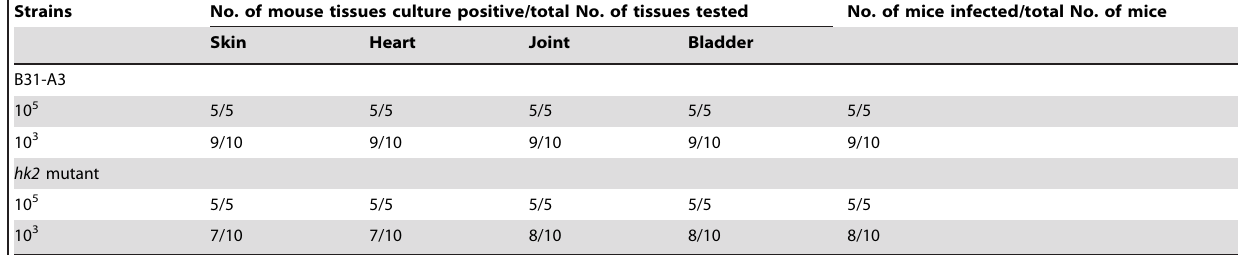
Strains No. of mouse tissues culture positive/total No. of tissues tested No. of mice infected/total No. of mice Skin